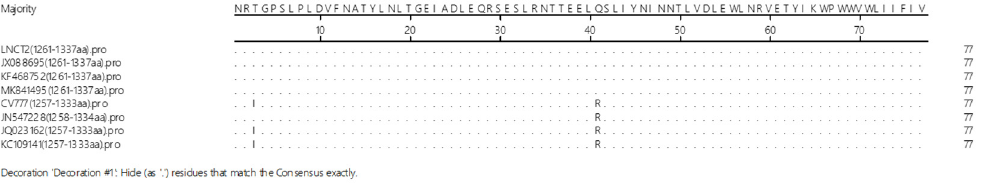
Figure 6. Comparison of the mAb 5F7 epitope amino acid sequence among the different PEDV strains. The mAb 5F7 epitope sequences from different strains of PEDV are shown.